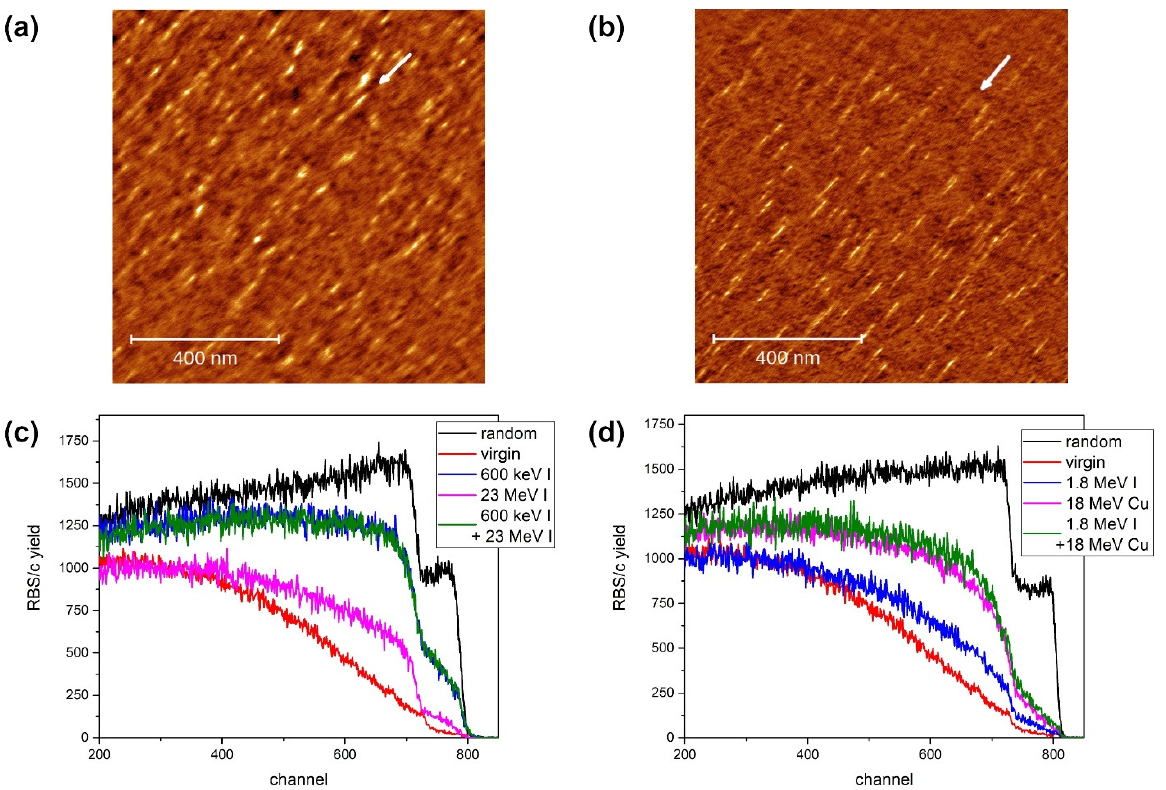
Figure 1. AFM images (1 µm × 1 µm, 1 nm false colour height scale) of ion tracks on Al 2 O 3 surface irradiated with ( a ) 5 MeV Si and ( b ) 12 MeV Si ion beams at a grazing incidence angle of 1.5 ◦ . The ion beam direction is indicated by an arrow. ( c ) RBS/c spectra of sequentially irradiated Al 2 O 3 with 600 keV I (10 14 ions/cm 2 ) and 23 MeV I (10 14 ions/cm 2 ). ( d ) RBS/c spectra of sequentially irradiated Al 2 O 3 with 1.8 MeV I (3 × 10 13 ions/cm 2 ) and 18 MeV Cu (5 × 10 13 ions/cm 2 ).